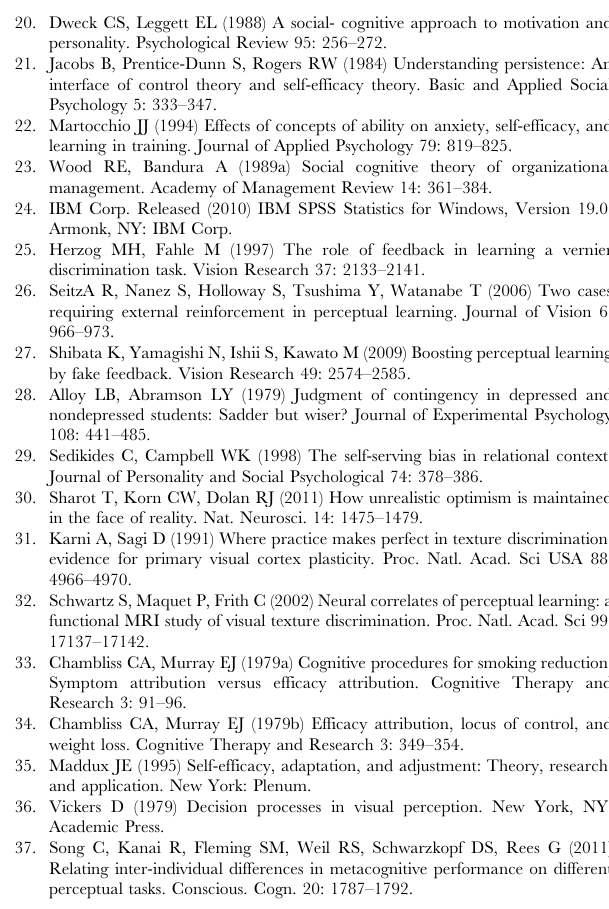
Figure S1 Contrast Self-Efficacy Questionnaire. (TIFF)